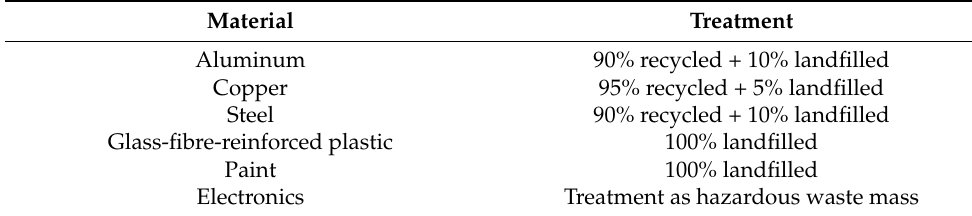
Table A8. Scenario B